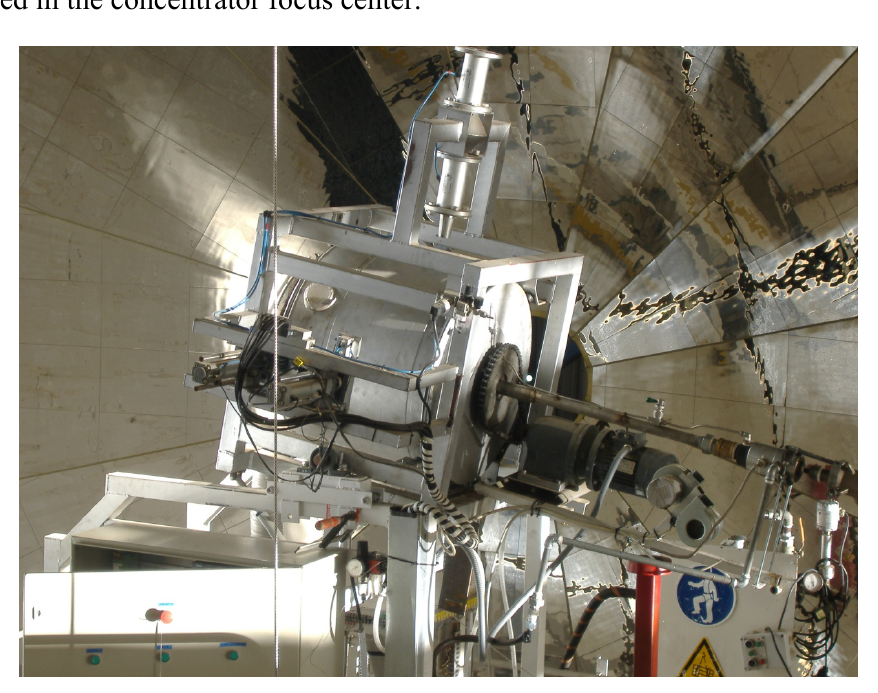
Figure 3. Detail of the rotary kiln and the quartz